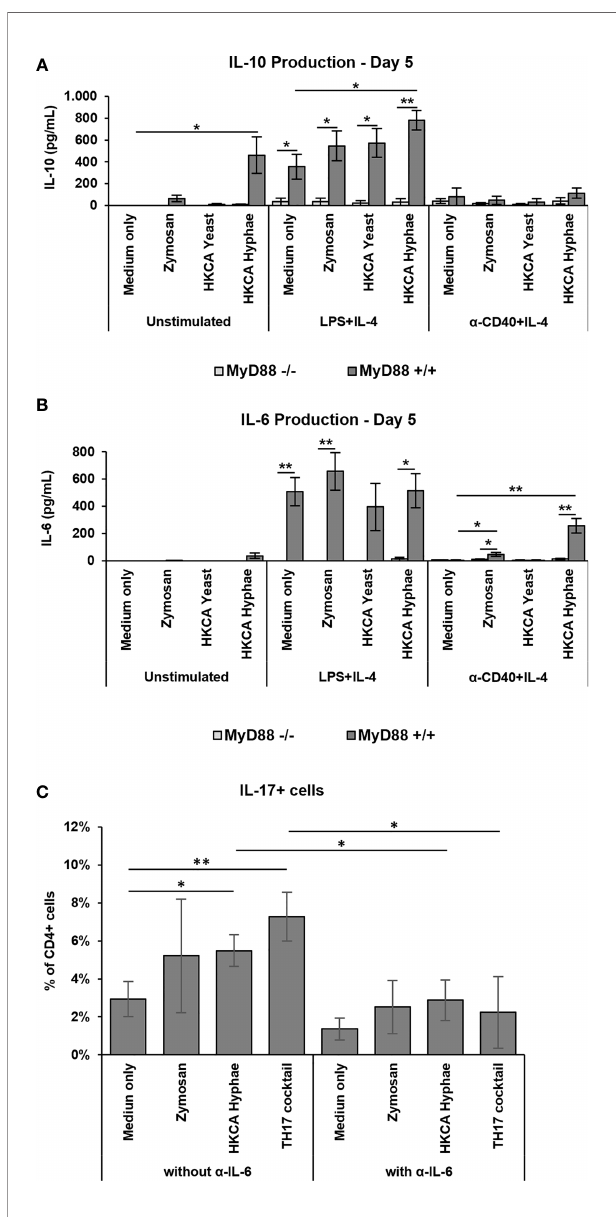
FIGURE 6 | Increased MyD88-dependent IL-6 production and IL-17 expression and T H 17 differentiation. Splenic B cells from MyD88 -/- and MyD88 +/+ mice were cultured either unstimulated or stimulated with LPS+IL-4 or anti-CD40+IL-4 in the presence of Zymosan, HKCA yeast or HKCA hyphae (A, B) . After 5 days of culture, the concentration of secreted IL-10 (A) and IL-6 (B) was measured by ELISA. Data represent mean ± SEM of 4 mice per genotype, with triplicate measurements performed for each mouse. (C) Splenic B and T cells from wildtype mice were cocultured with anti-CD3 ϵ and anti-IgM in the presence of Zymosan, HKCA hyphae or a T H 17 differentiation inducing cocktail (anti-IL-4, anti-INF- g , anti-IL-12, TGF- b 1 and IL-6). The same culture conditions were also used in combination with a neutralizing IL-6 antibody. The percentage of IL-17+ cells among CD4+ T cells was measured by fl ow cytometry after 4 days of culture. For representative plots and gating strategy, see Supplementary Figure S5D . Data represent mean ± standard deviation (SD) of 3 mice with duplicate measurements performed for each condition. *p < 0.05, **p <